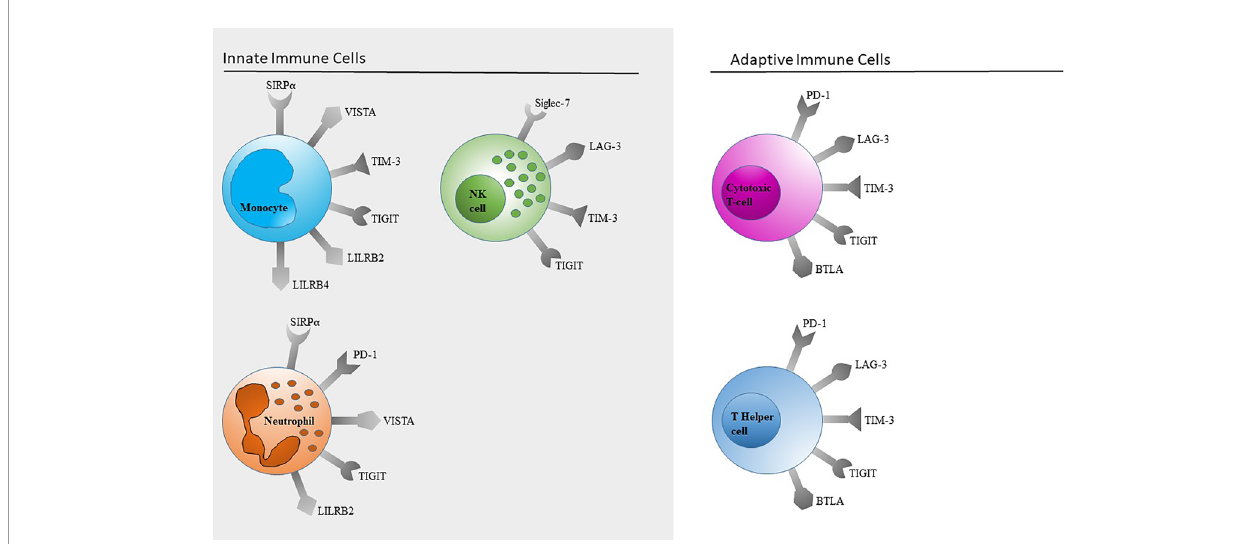
FIGURE 5 | Schematic overview of immune checkpoints expressed on innate and adaptive immune cells. Only immune checkpoints included in our panels ( Table 1 ) are shown. This selection is by no means a complete representation of all immune